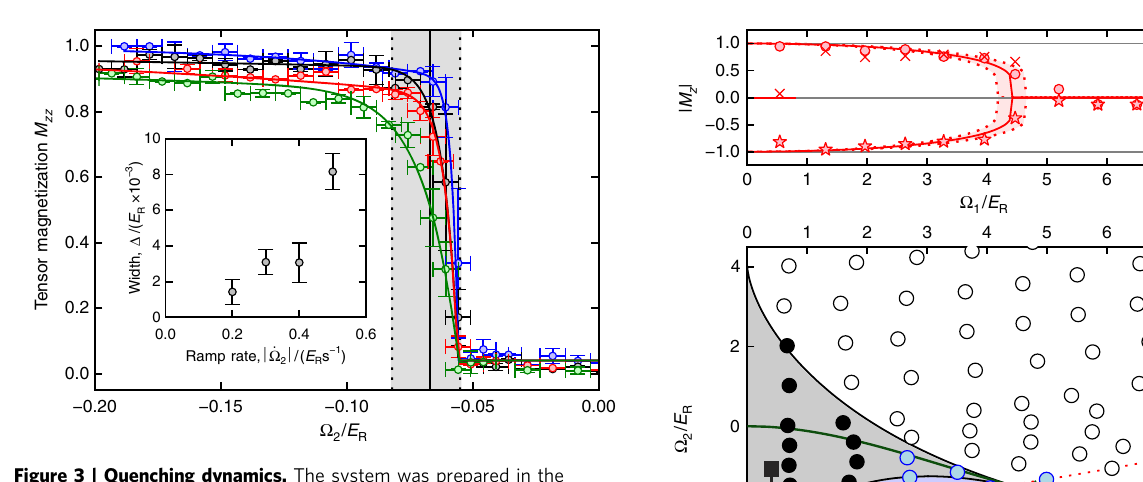
Figure 3 | Quenching dynamics. The system was prepared in the unmagnetized phase with O 1 ¼ 0.74(8) E R and O 2 was ramped through the phase transition at ramp-rates d O 2 /d t ¼ (cid:4) 0.2, (cid:4) 0.3, (cid:4) 0.4, and (cid:4) 0.5 E R s (cid:4) 1 (blue, black, red, and green symbols, respectively). The curves are guides to the eye. The inset shows the decreasing width, defined as the required interval for the curve to fall from 50 to 20% of its full range, of the first-order transition as the ramp-rate decreases. Vertical error bars correspond to one standard deviation of up to 10 measurements, and horizontal error bars correspond to a systematic error of 0.005 E R from fluctuations in the bias field. Error bars on the inset panel correspond to the 95% confidence interval on the fitting function of the quenching data.